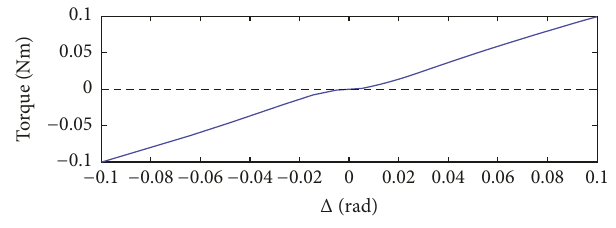
Figure 4: Backlash effect as a torque to the